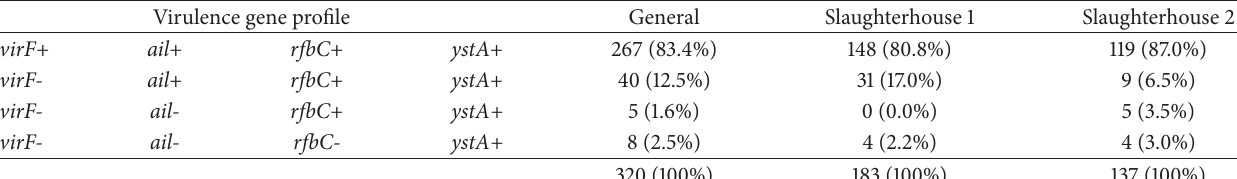
Table 1: Virulence gene profiles obtained through PCR on Yersinia enterocolitica biotype 4/O:3